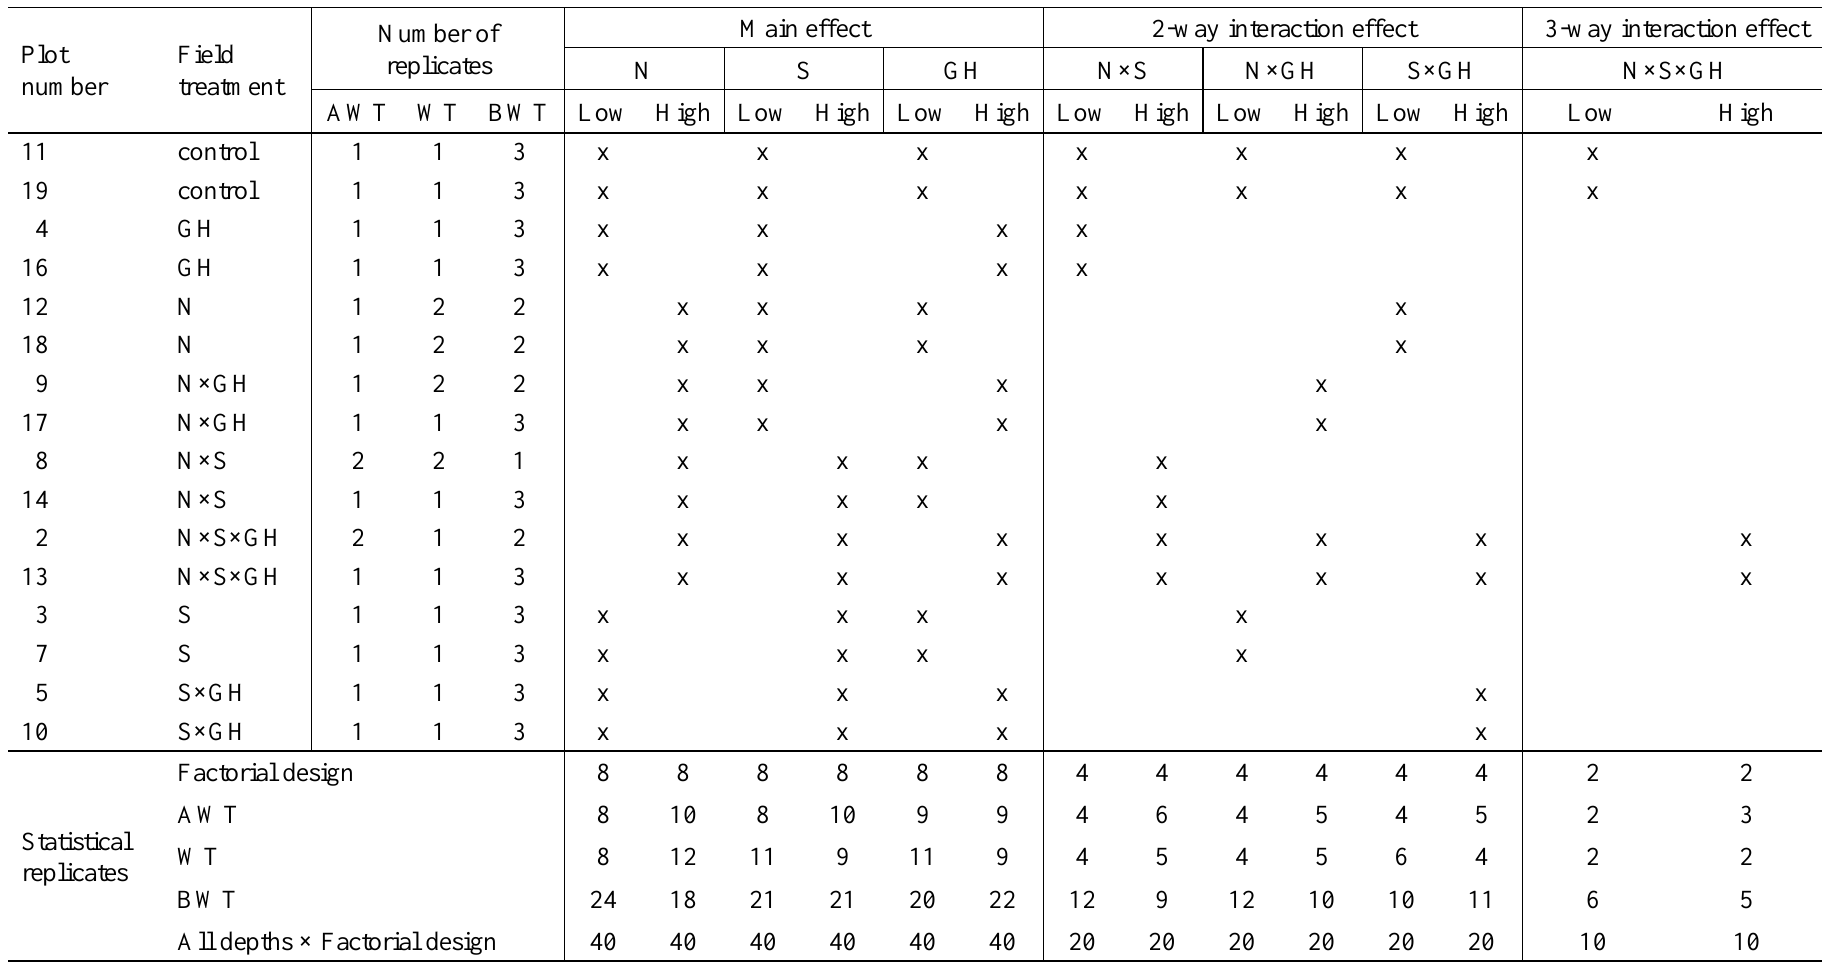
Table A1. Evaluation matrix for the treatments effect. Horizons in the peat profile: AWT = above the annual mean water table level; WT = layer around the annual mean water table level; BWT = below the annual mean water table level. ‘Low’ and ‘High’ refer to the treatment levels, involving the following application rates: for sulphur (S), Low (ambient) = 3 kg ha -1 yr -1 , High = 20 kg ha -1 yr -1 ; for nitrogen (N), Low (ambient) = 2 kg ha -1 yr -1 , High = 30 kg ha -1 yr -1 ; and for warming (GH), Low = ambient, High = with a transparent cover (see Methods for further